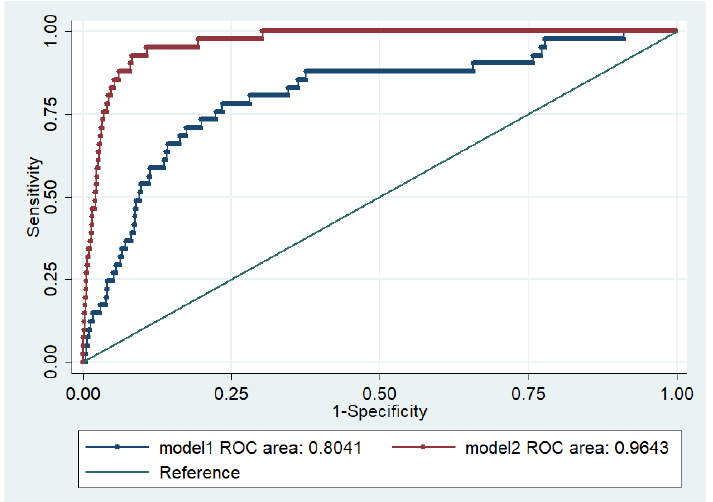
Figure 1. ROC curve for the predictive models for hospital mortality. Note: Model 1 included PLR, LMR and NLR. Model 2 included PLR, LMR, NLR, SOFA and MELD scores. AUC, area under the curve. ROC, receiving operating characteristic.